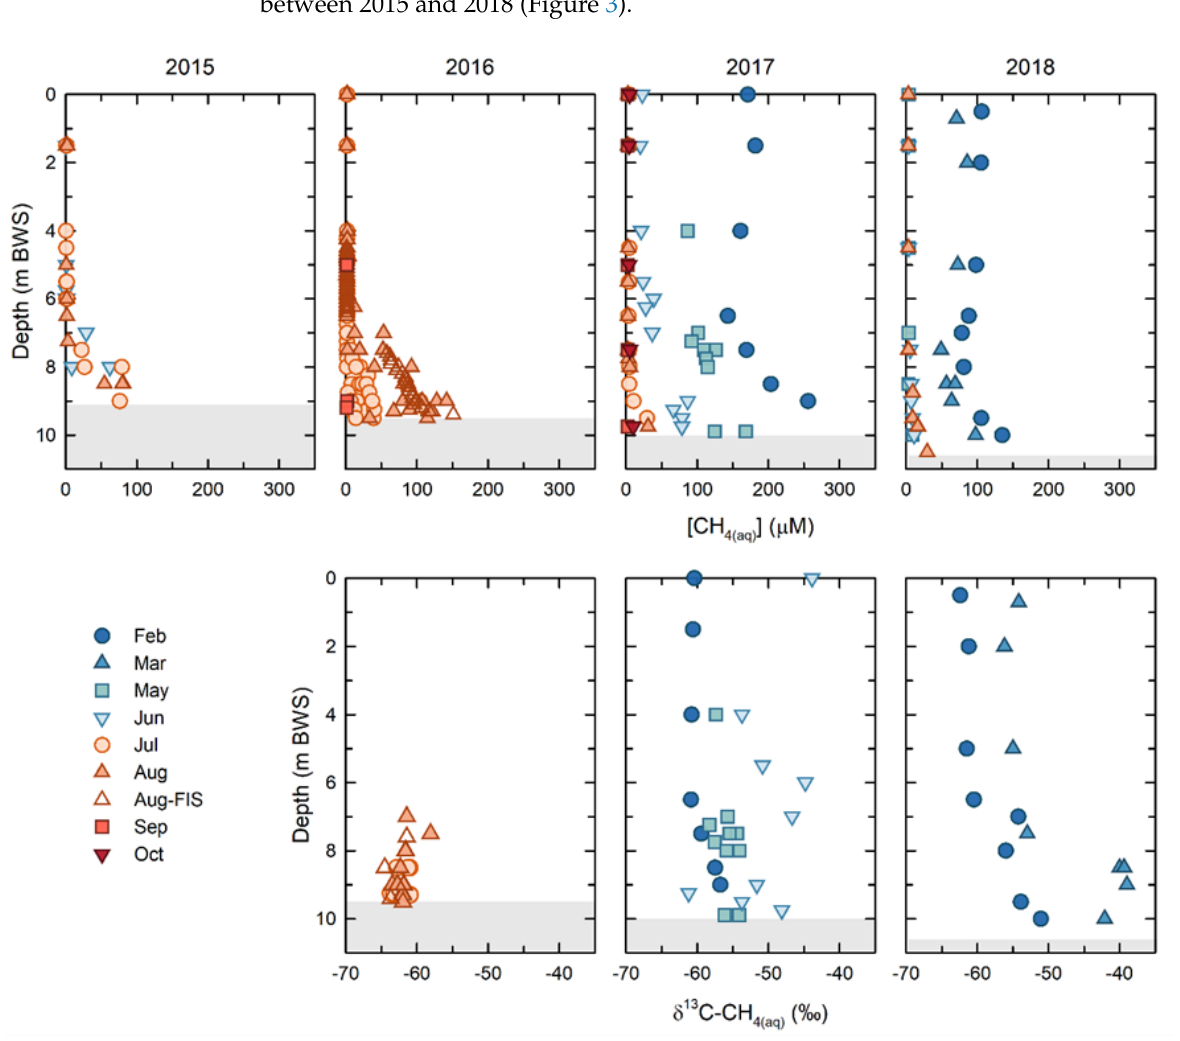
Figure 3. Dissolved methane concentrations ( µ M) and isotopic compositions ( δ 13 C) for 2015, 2016, 2017, and 2018. Under-ice samples (February and March) were only obtained in 2017 and 2018. The shaded region at the bottom shows the depth of the FFT and its settlement over